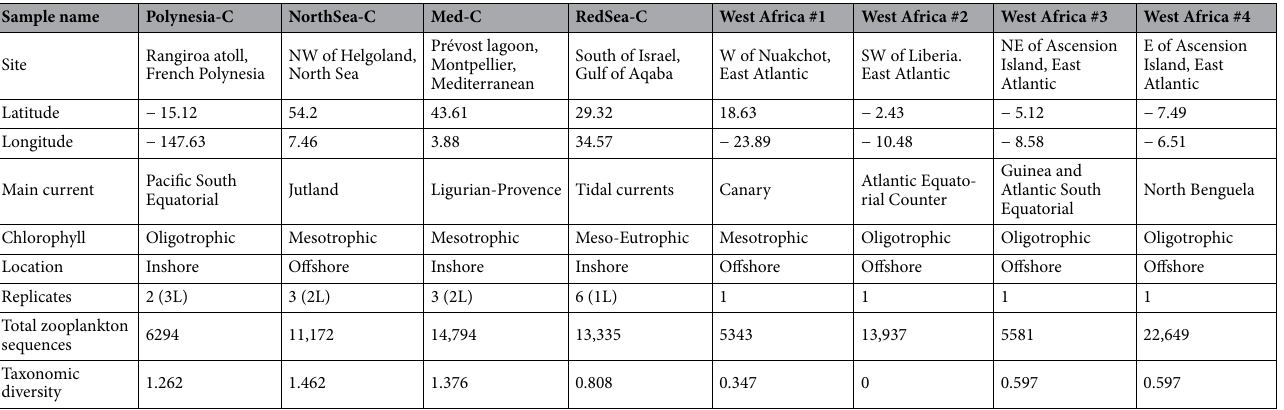
Table 1. Water samples analyzed (6 L). Taxonomic diversity as Brillouin D-index calculated from the number of species by